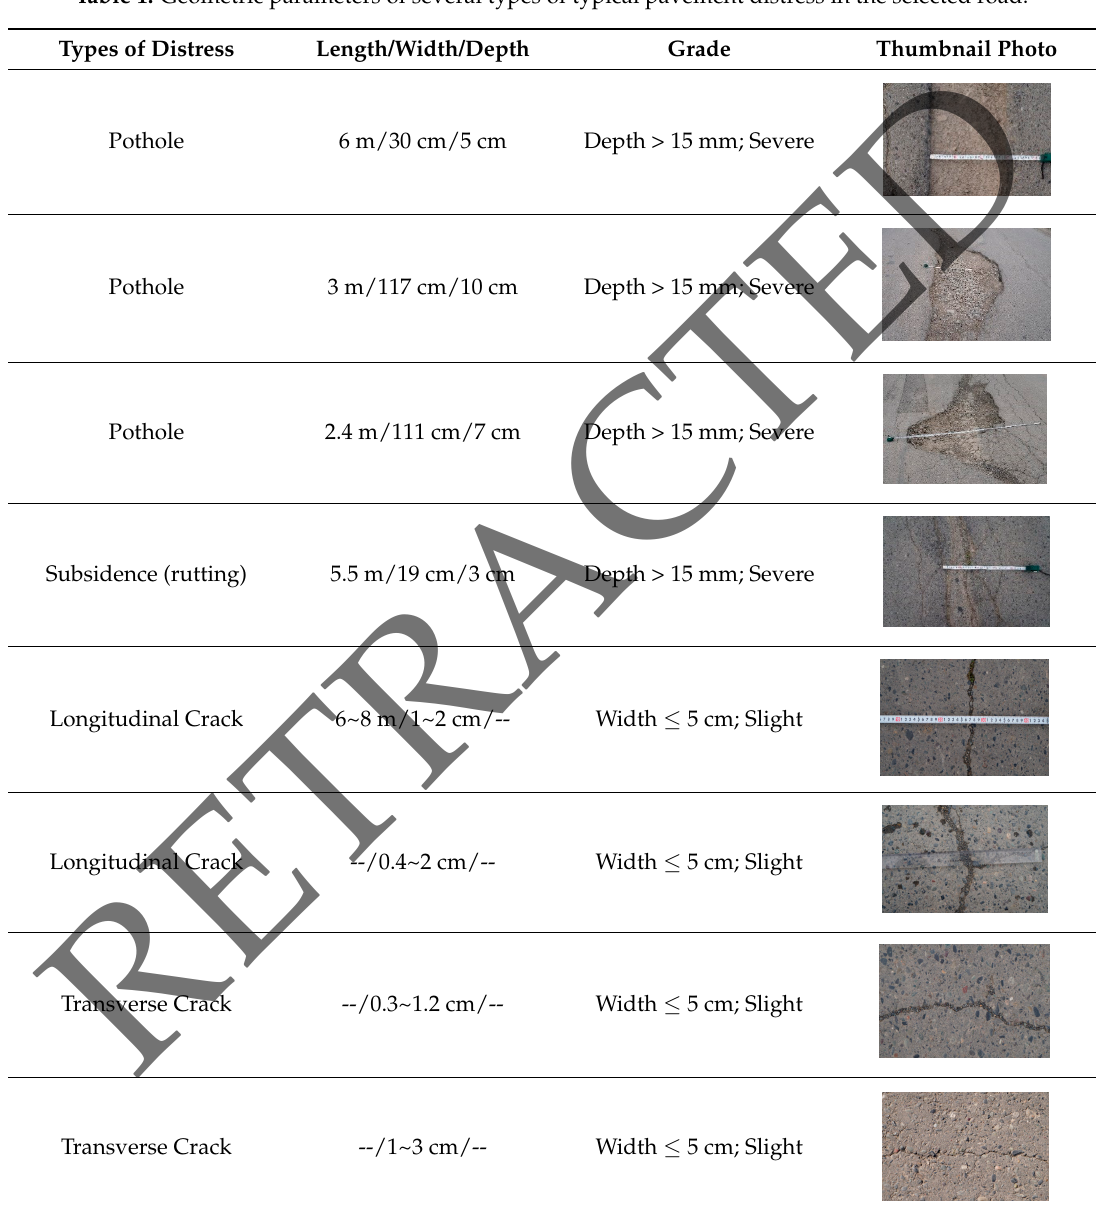
Table 1. Geometric parameters of several types of typical pavement distress in the selected road.